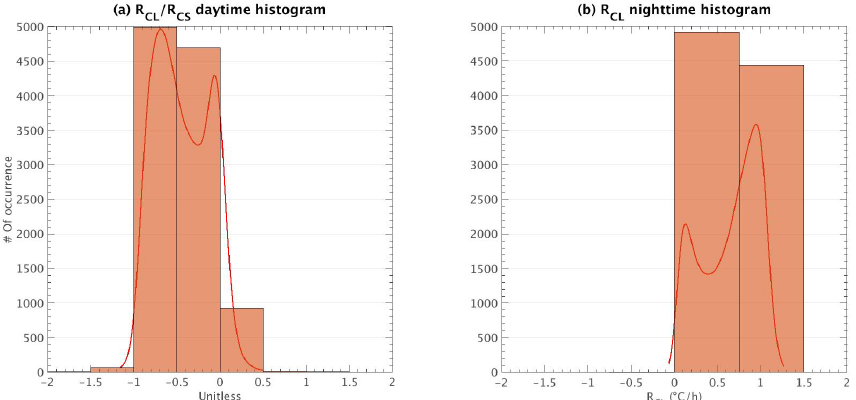
Figure C1. (a) Daytime histogram of R CL and (b) nighttime histogram of R CL . The red line in both figures represents the PDF, and the R CS rectangular semi-transparent brown boxes represent the different bins created to analyze cloud influence. These histograms are built